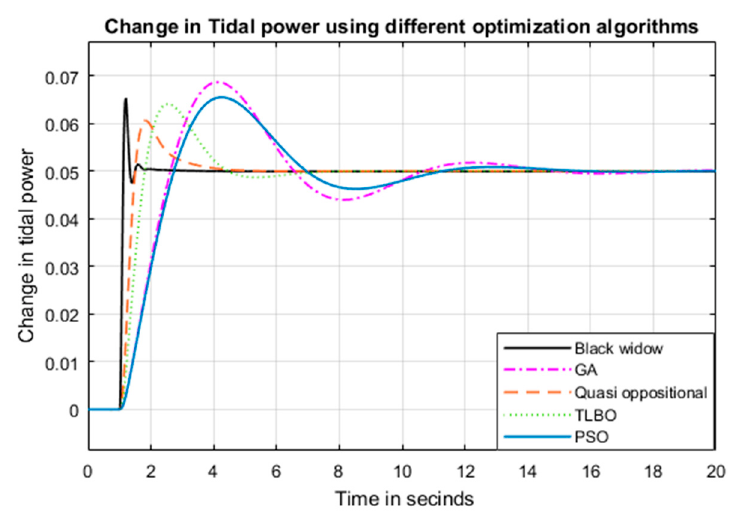
Figure 11. Change in tidal power using different optimization techniques.